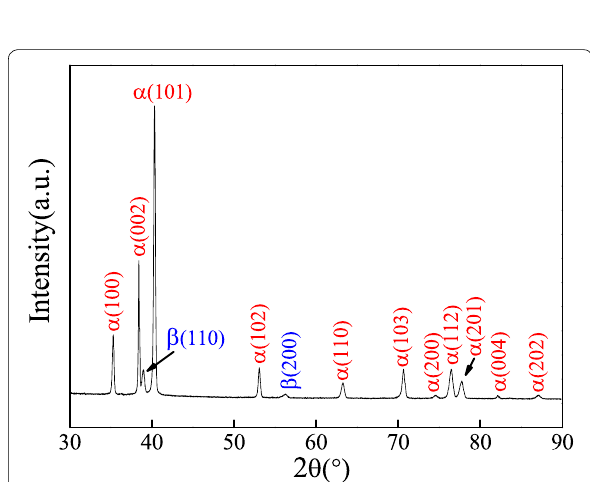
Figure 2 X-ray diffraction analysis of TA19 titanium alloy